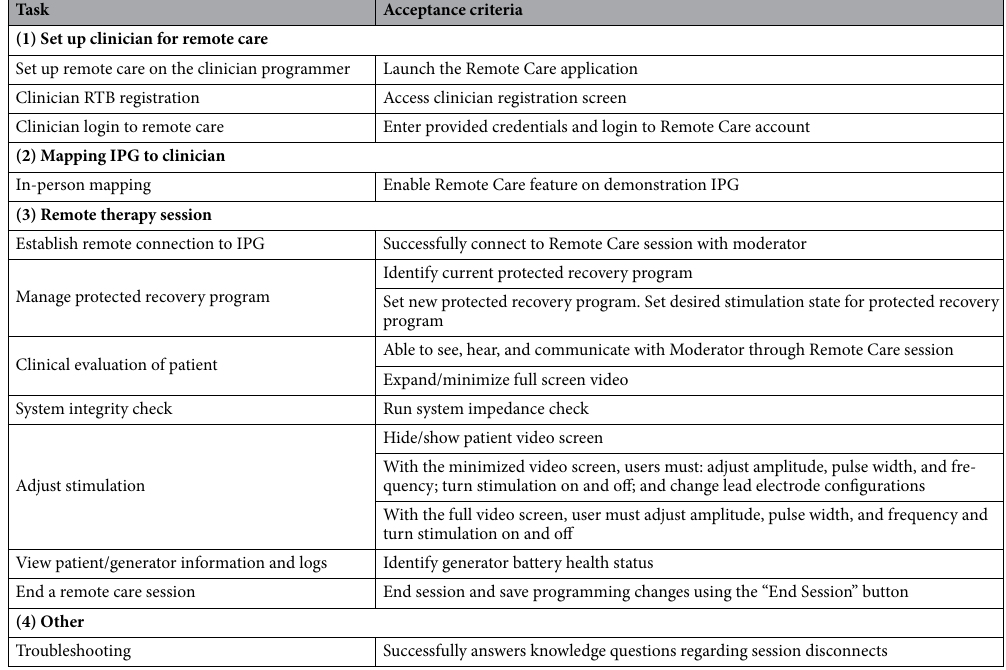
Table 3. Task description and use scenarios for usability testing with clinicians.